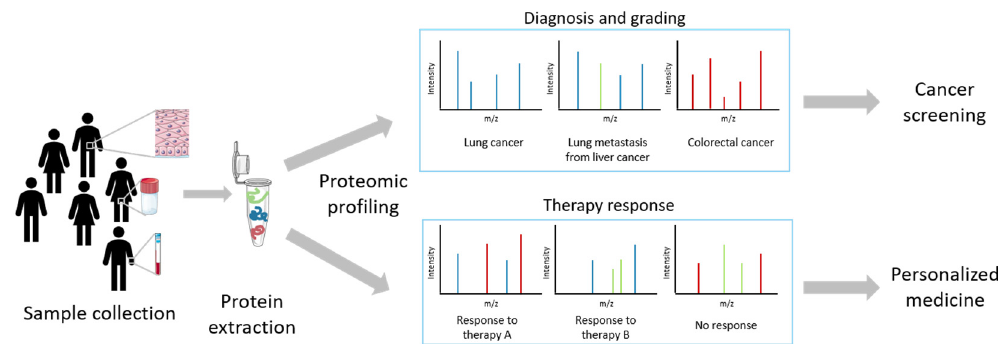
Figure 1. A schematic overview of the implementation of proteomics in cancer screening and personalized medicine. Samples can be biological fluids (f.e. blood and urine) or tissue biopsies from which proteins are extracted to perform proteomic profiling, in this example with mass spectrometry. Different mass spectra can enable diagnosis and grading for cancer screening or assess efficacy and toxicity of therapeutic agents.